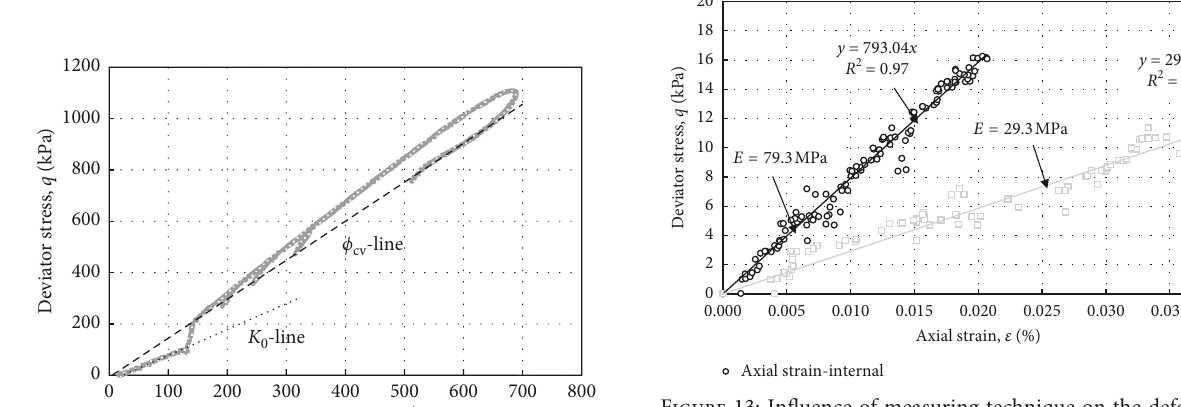
Figure 13: Influence of measuring technique on the deformation